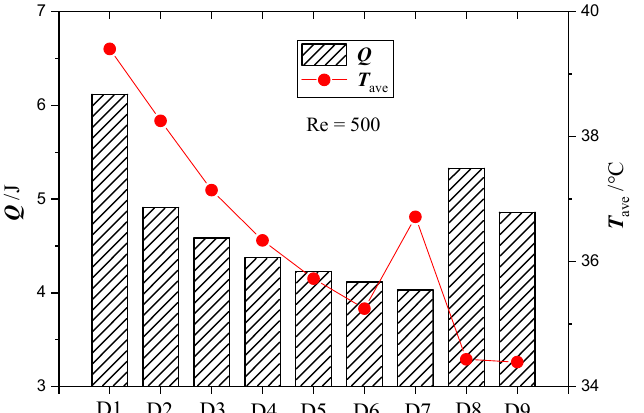
Figure 10. Temporal variation of temperature maldistribution parameter for different designs at Re = 500.